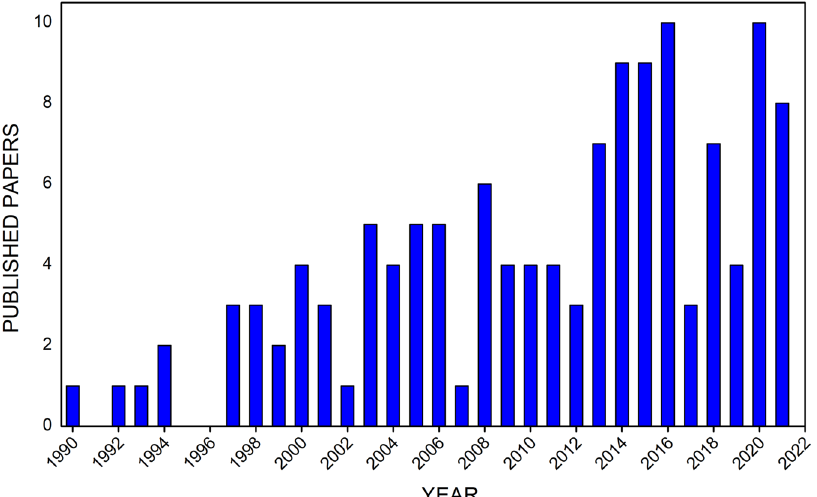
Fig. 1 Papers dealing with bone tissue engineering in microgravity. Timeline of published papers from the PubMed website using the key “ microgravity bone tissue engineering ”